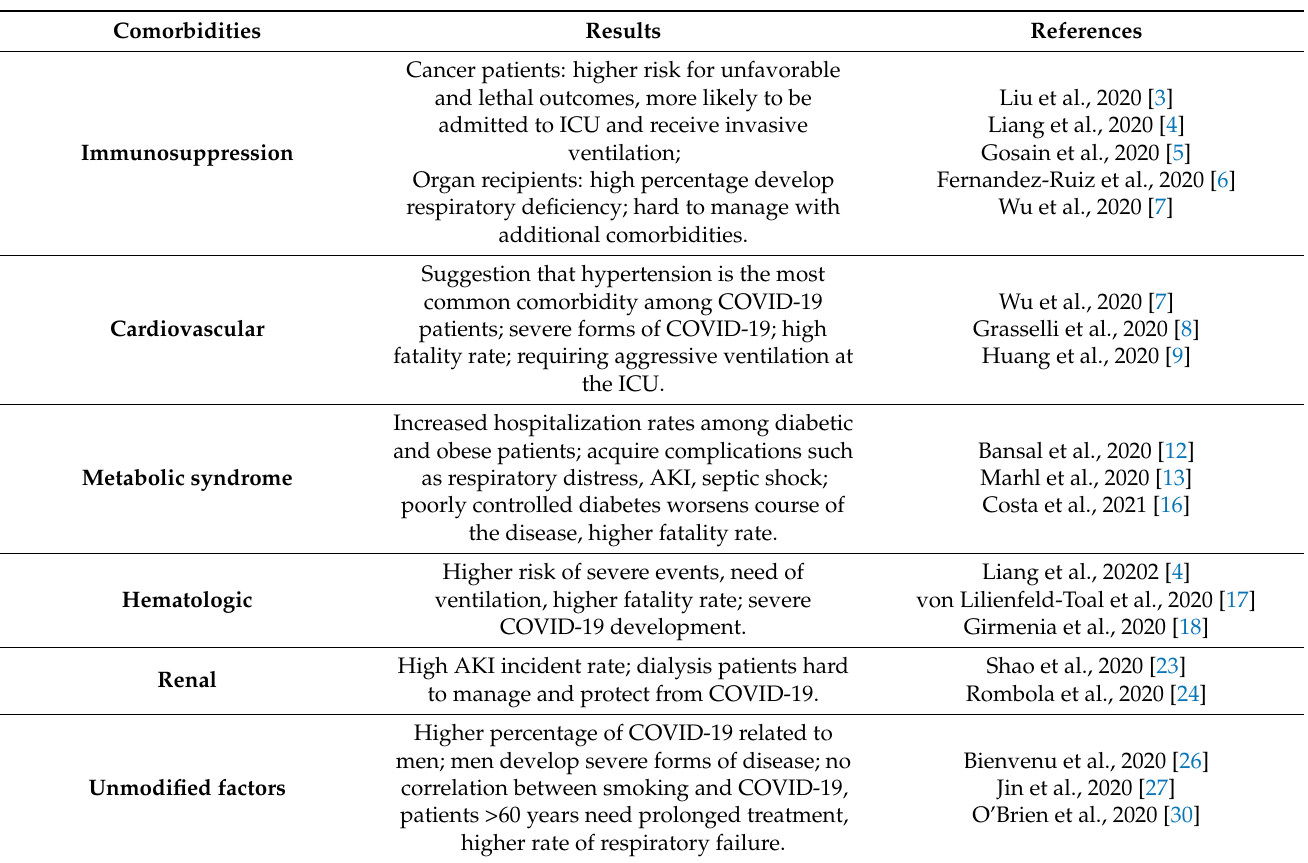
Table 2. Summary of the main results related to